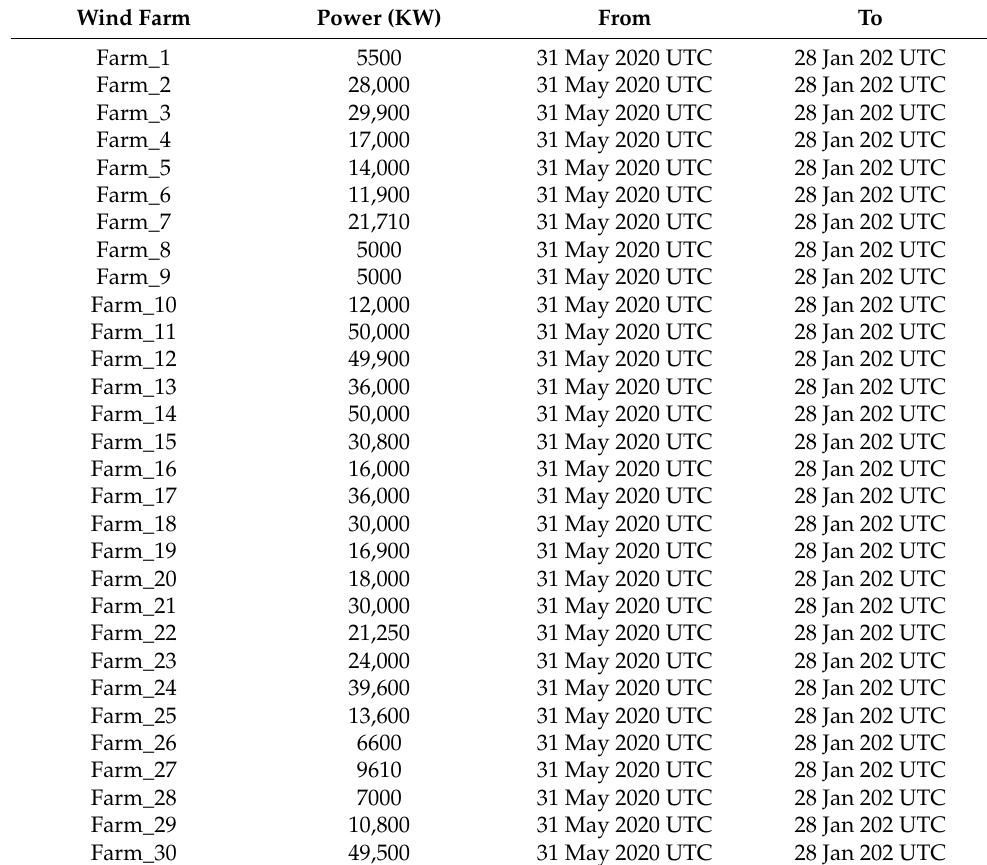
Table 4. Wind farms analyzed using the EOLO wind predictor, including the nominal power (KW) of each wind farm and the study period (from–to)